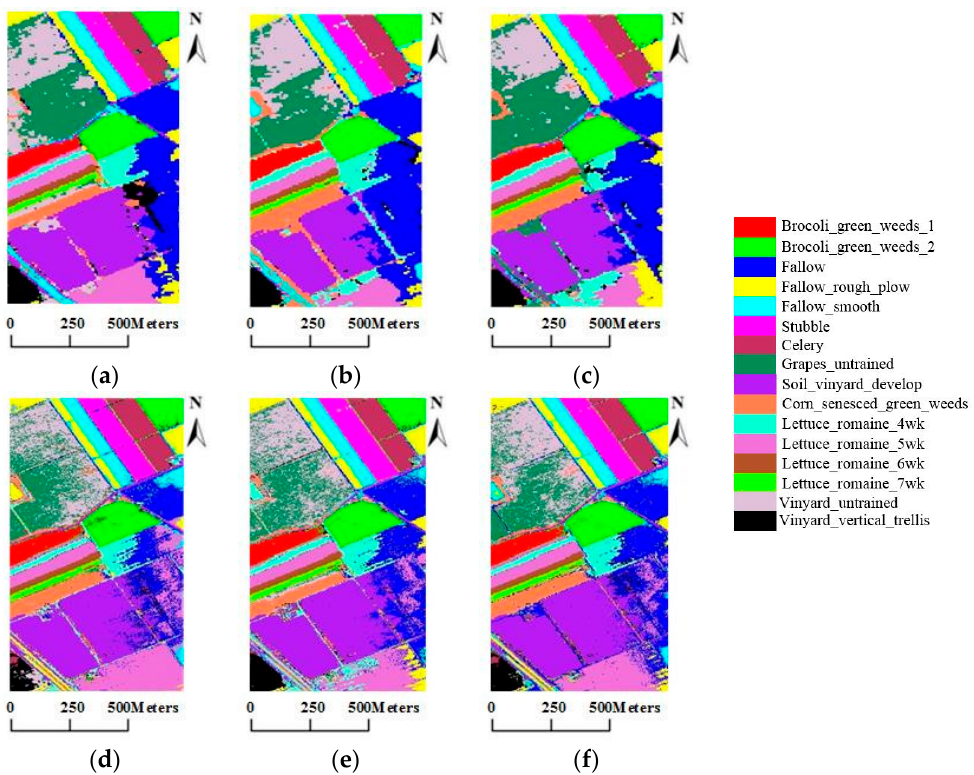
Figure 10. Classification maps for all of the methods with the AVIRIS Salinas Valley dataset using 5, 10 and 15 labeled samples per class. ( a ) TT_AL_MSH_MKE ( L = 5); ( b ) TT_AL_MSH_MKE ( L = 10);